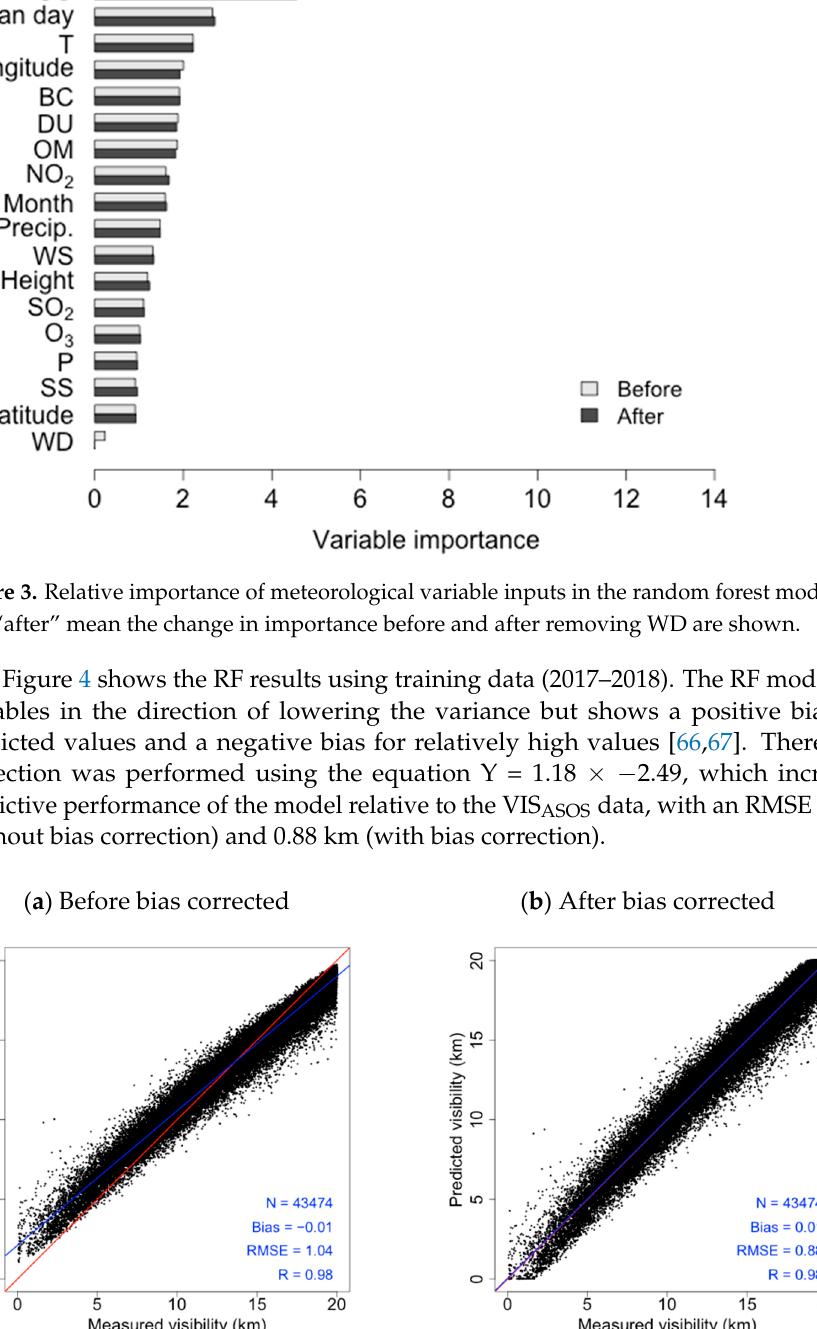
model. RH has a well-known influence on visibility, and among the air pollutants, SU and